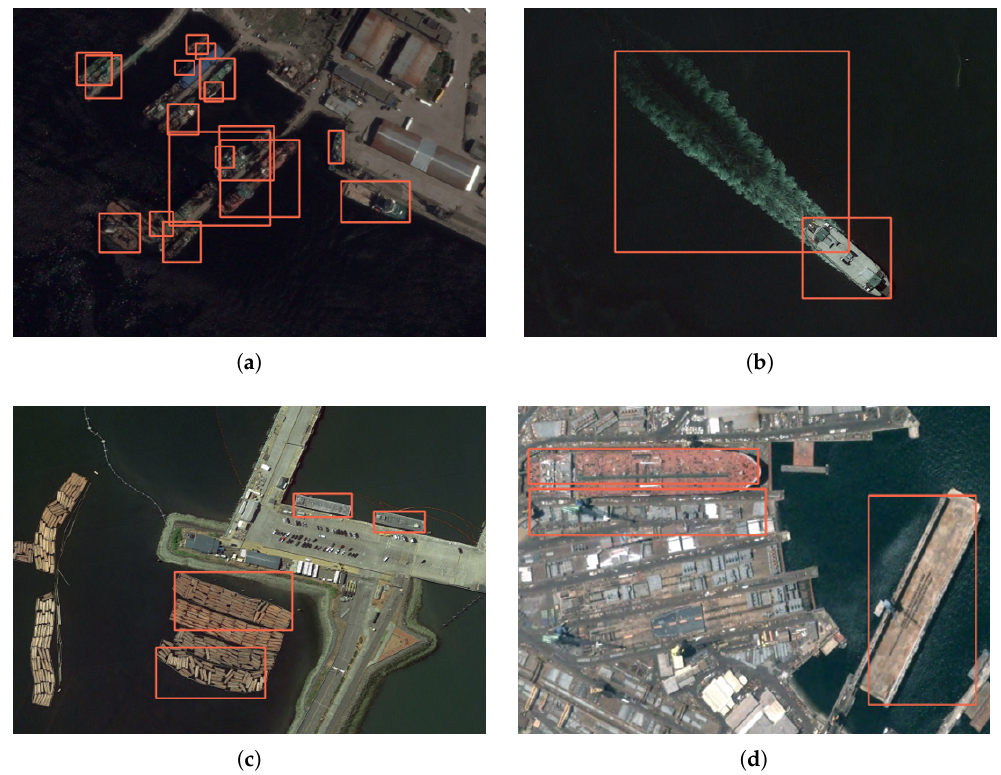
Figure 8. Examples of several failure cases on HRSC2016-MS dataset. ( a ) False and duplicate detection due to densely arranged objects. ( b ) False detection due to the sea wave trail. ( c ) False detection due to similar objects on the ocean. ( d ) False detection due to similar objects on